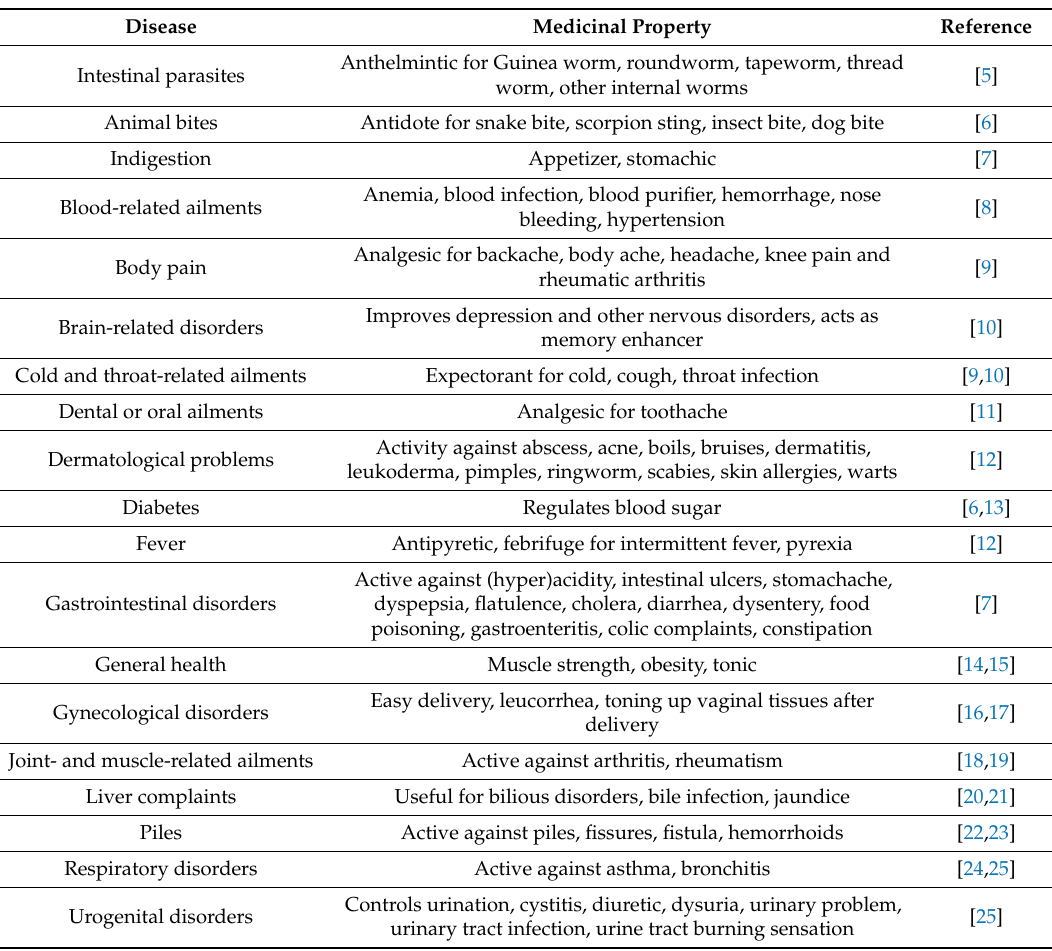
Table 1. Medicinal properties of H.